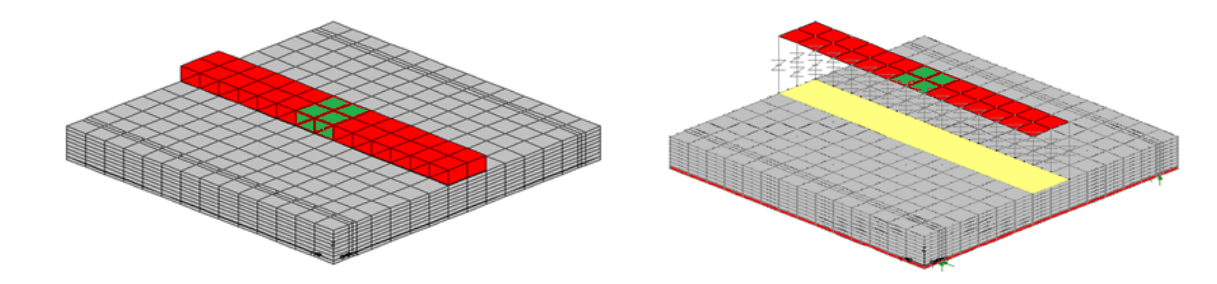
Figure 17: The reference specimen mesh Figure 18: The strengthened specimen mesh